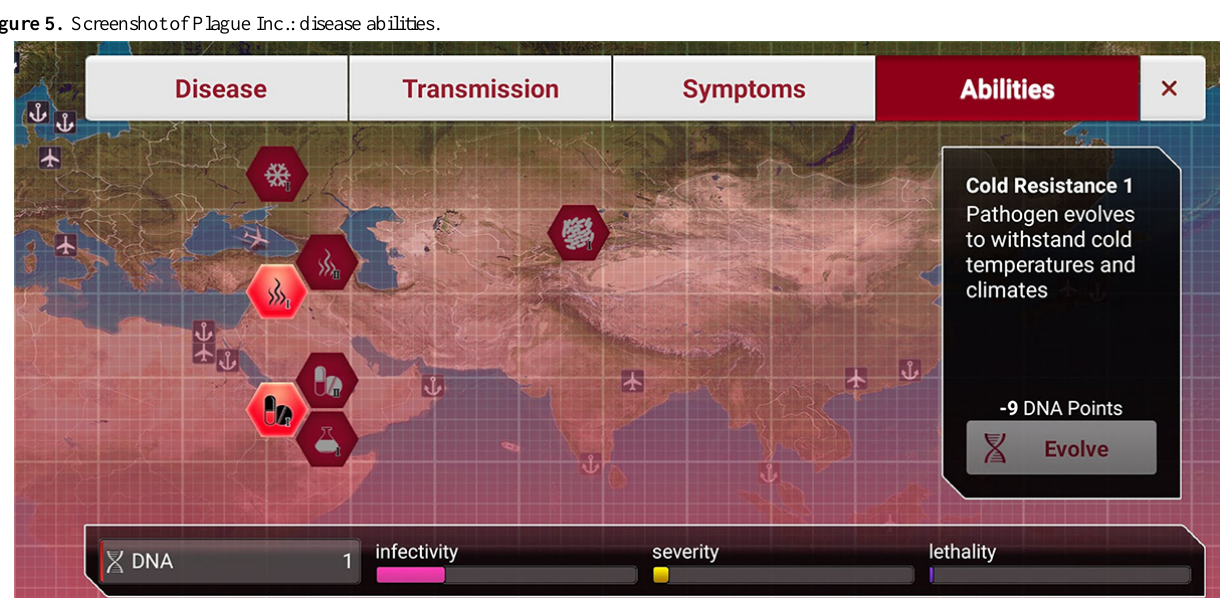
Figure 5. Screenshot of Plague Inc.: disease